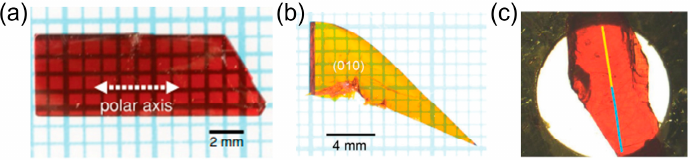
Figure 18. Crystal photos of ( a ) PMB-T [46]; ( b ) OHB-TFO [49]; ( c ) EHPSI-4NBS [52].